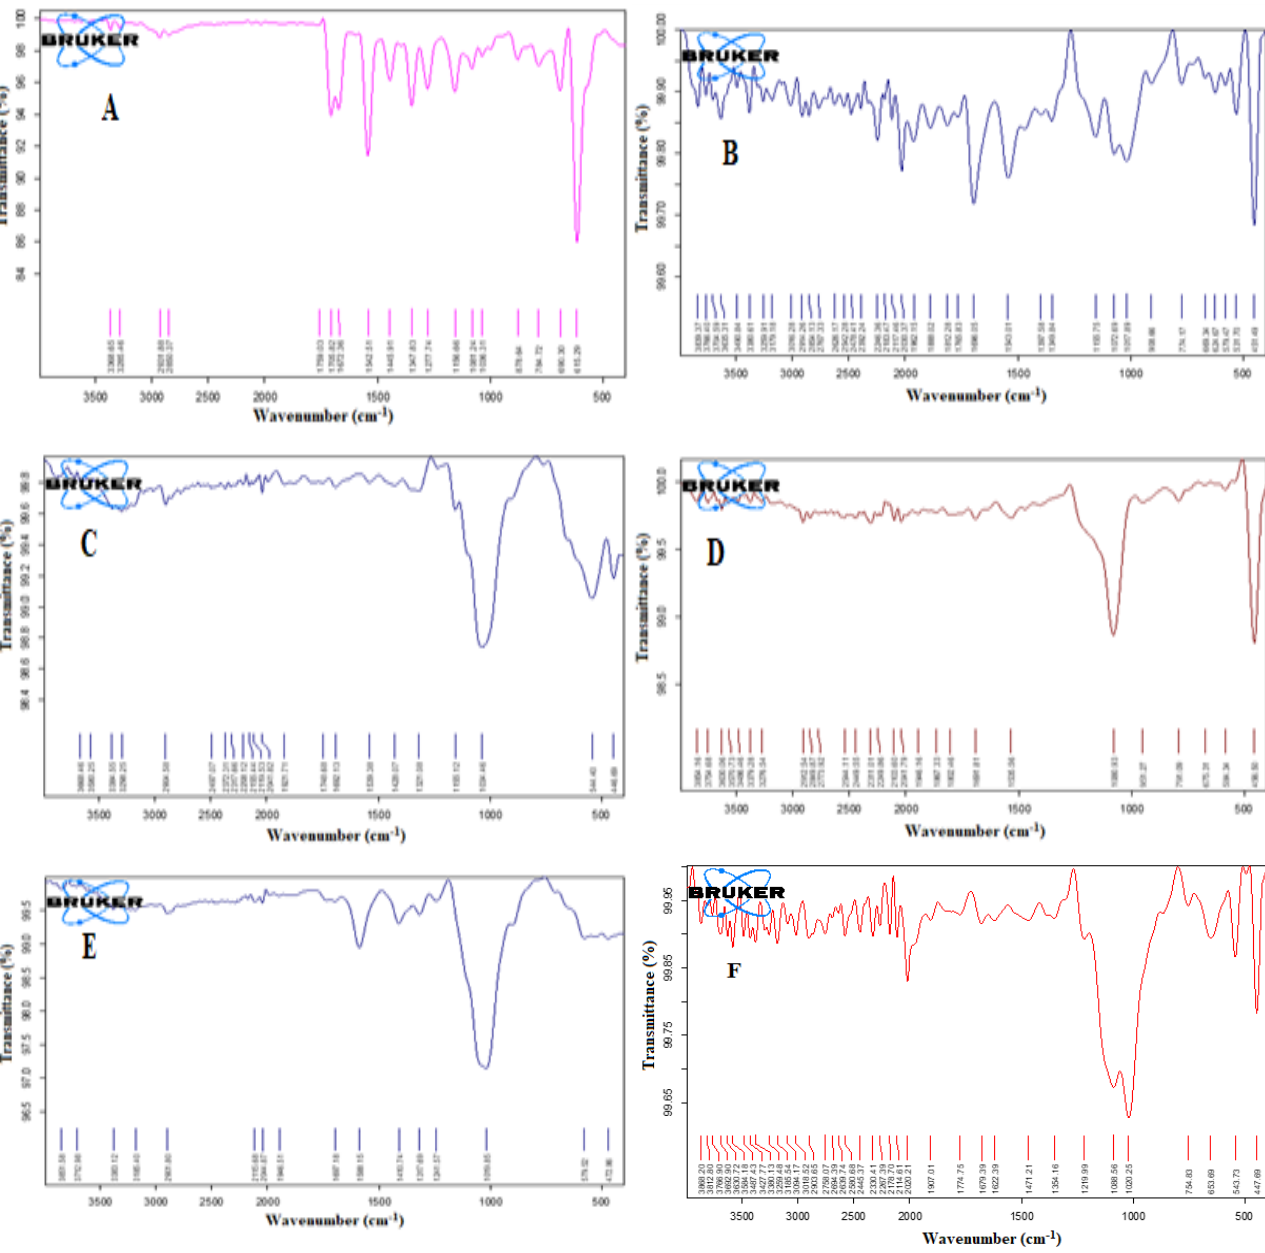
Figure 7. FT-IR spectra of Glimepiride ( A ), Neusilin ( B ), Avicel ( C ), FujiSil ( D ), Ac-Di-Sol ( E ), and the optimized liquisolid tablet ( F )